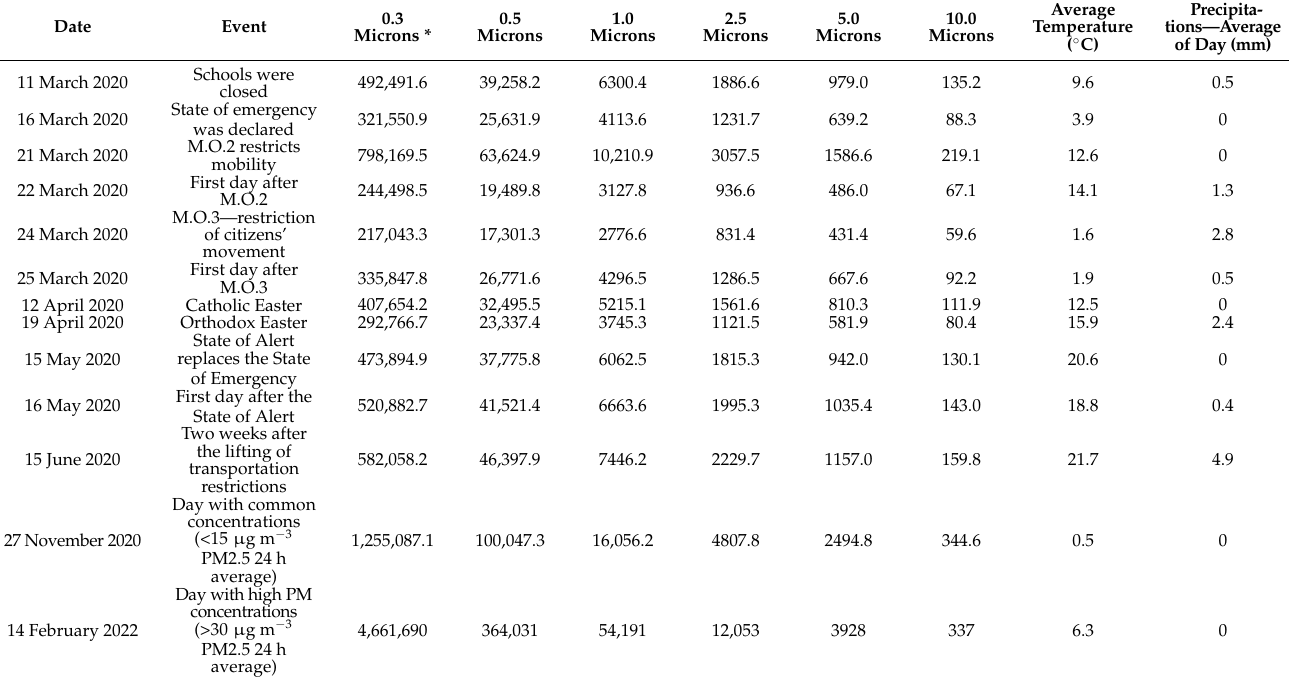
Table 1. Particle number concentration assessment using the Lighthouse HH 3016 IAQ (aver- ages of measurements performed between 8.00 and 11.00 a.m. in the locations of the monitoring stations)—particle number concentration PN/cm 3 ∆ delta—differential (* the counting efficiency for the 0.3 microns is 50% according to the manufacturer); average temperature and precipitation during the day were retrieved from ERA 5 reanalysis